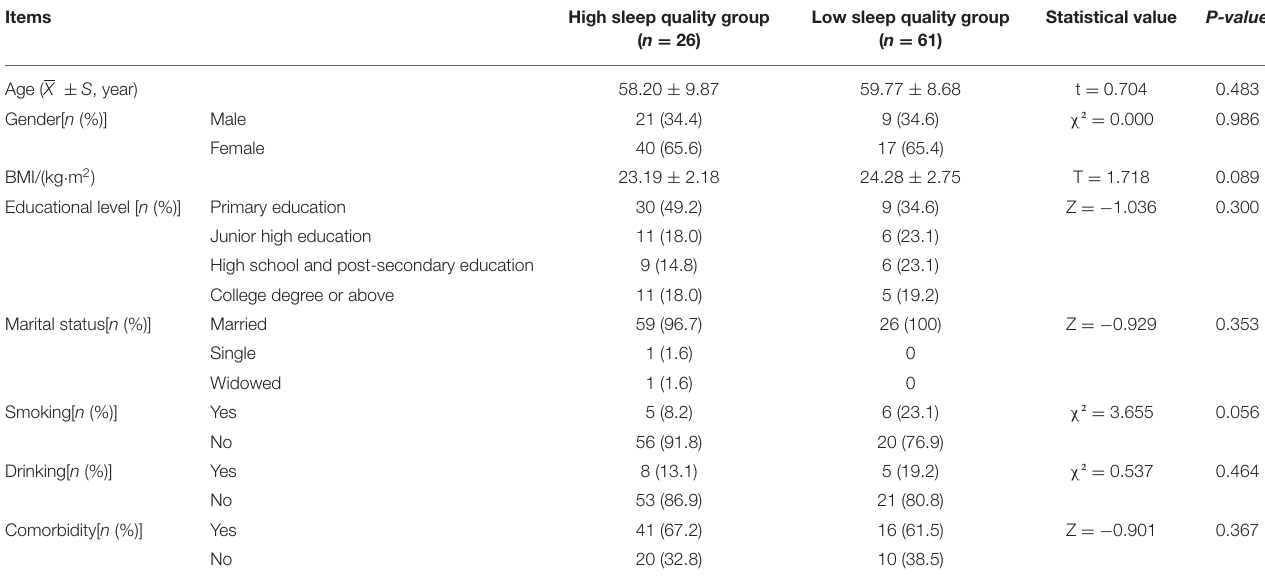
TABLE 1 | Comparison of general data of patients in two groups ( n = 87). Items